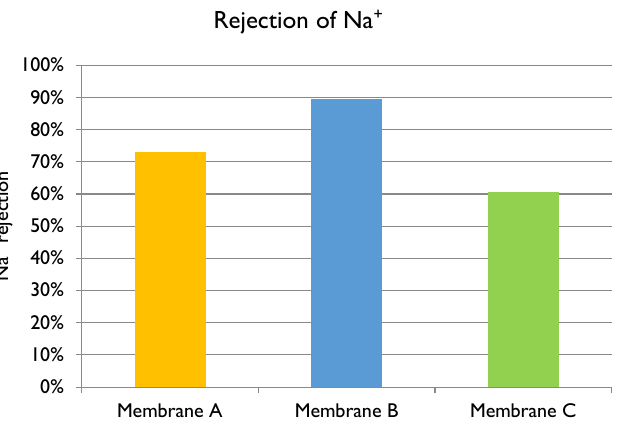
Figure 12. Rejection of Na + for membranes A, B, and C in the second experiment.